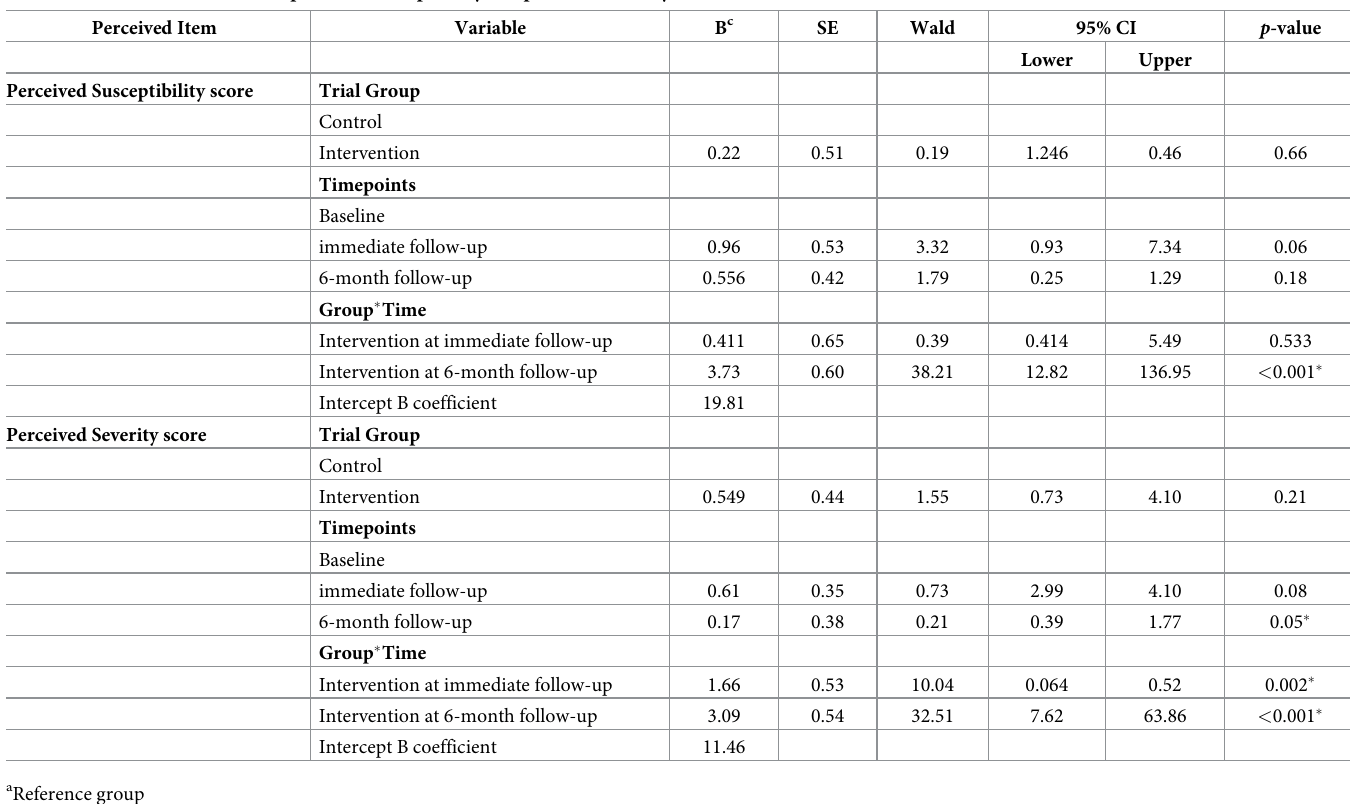
Table 7. Effectiveness of HEBI on perceived susceptibility and perceived severity score. Perceived